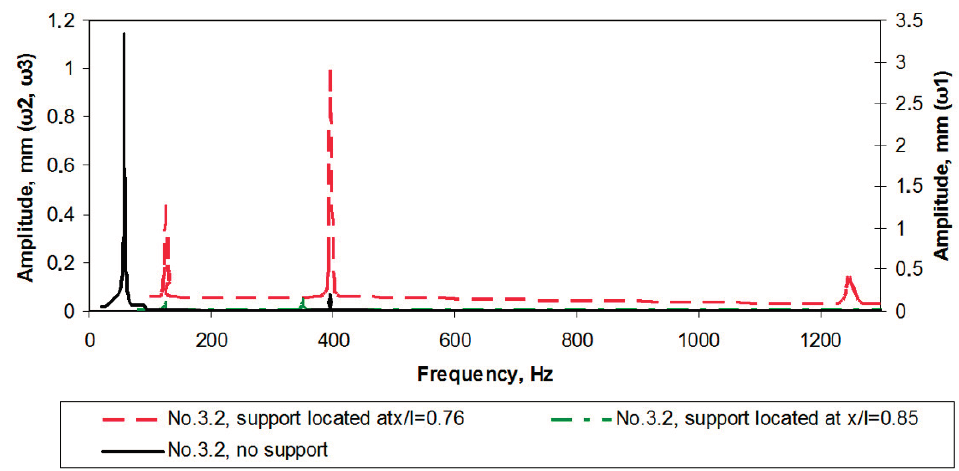
Figure 17. Amplitude-frequency response characteristics for the optimally